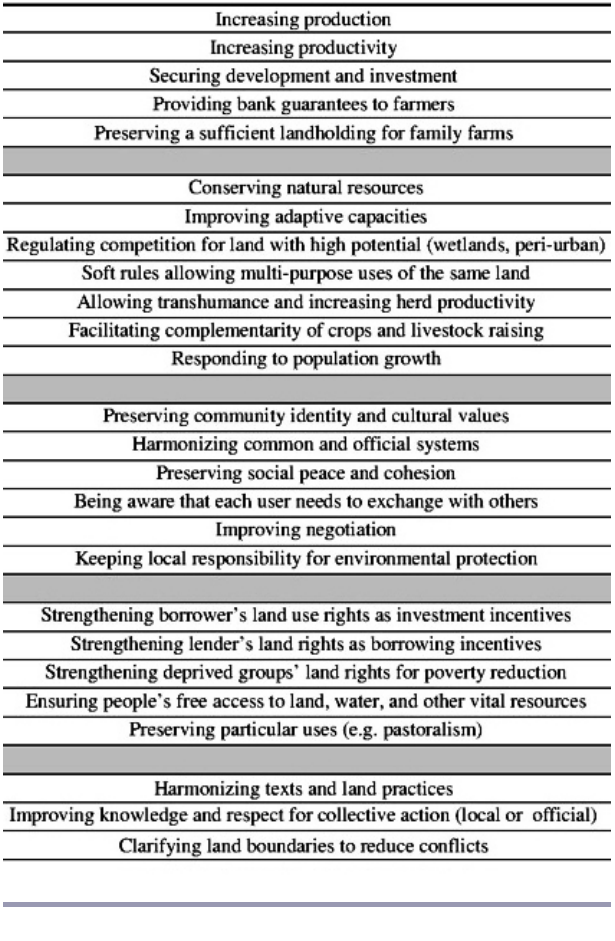
Fig. 2 . The board used for the role-playing